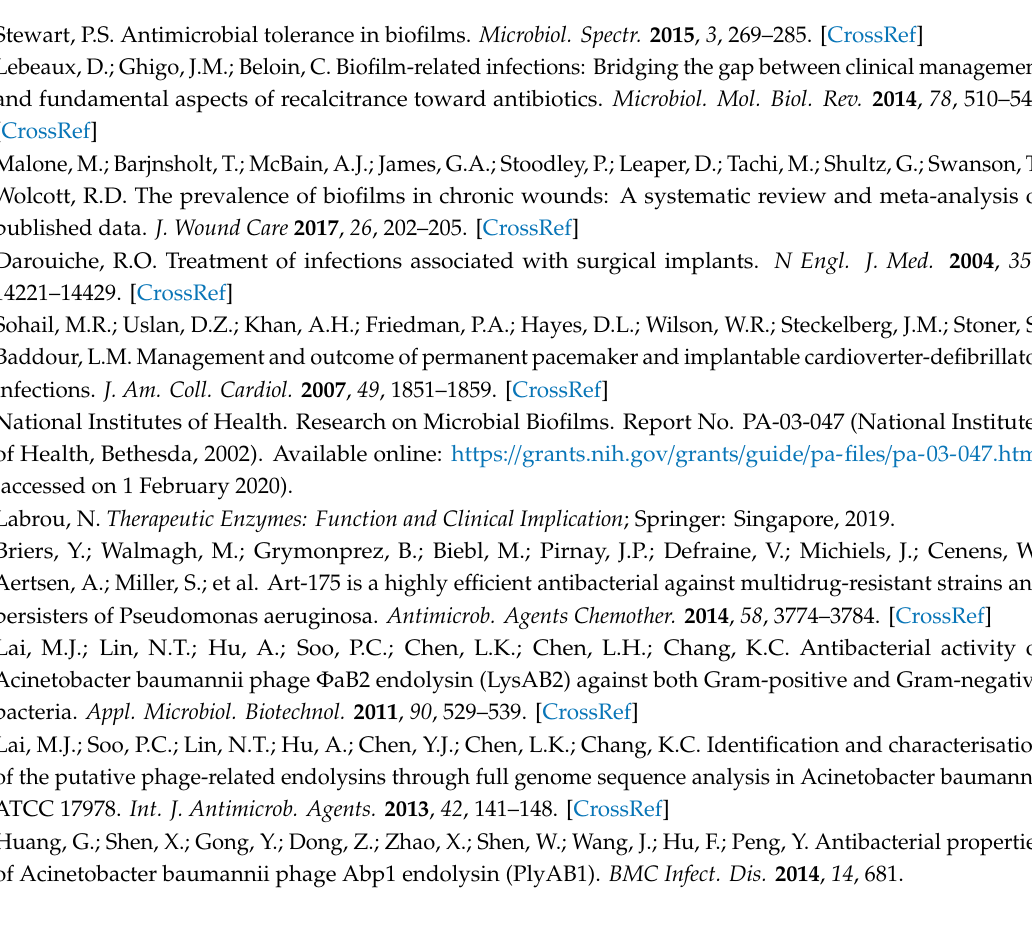
Table S1: K. pneumoniae strain Ts 141-14 MIC distribution for antibiotics; Table S2: Count of culturable bacteria in the formed biofilms in di ff usion chambers in vivo during the therapy; Table S3: Dynamics of the biofilms density in di ff usion chambers in vivo during the therapy; Figure S1: Schematic structure of the di ff usion camera; Figure S2: Intraoperative view of the di ff usion chambers in abdominal cavity on the 2nd day of treatment; Figure S3: Intraoperative view of the di ff usion chambers in the abdominal cavity on the 5th day of treatment; Figure S4: Antibacterial activity of amikacin